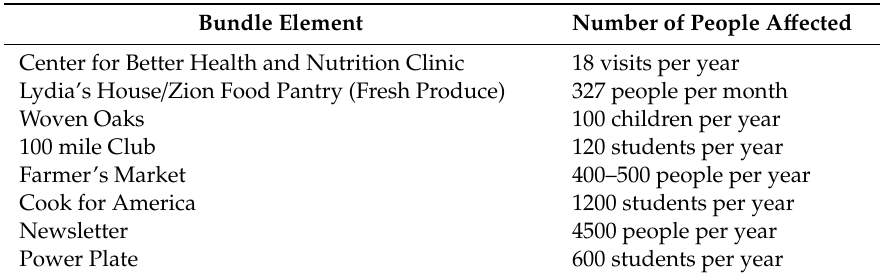
Table 1. Summary of the components of the “Norwood Bundle”.